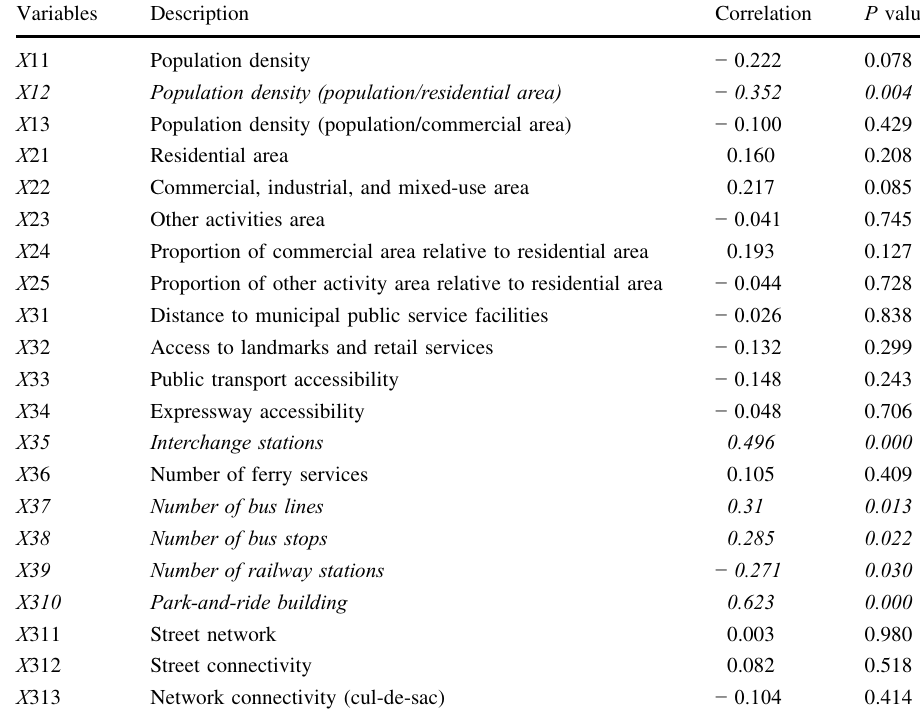
Table 5 Correlations of 3D